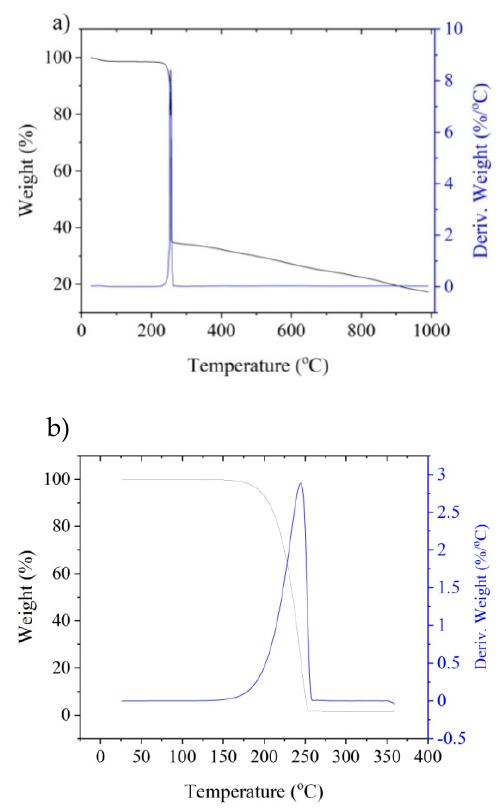
Figure 2. Thermogravimetric (TG) curves for: ( a ) compound A; ( b ) compound B.